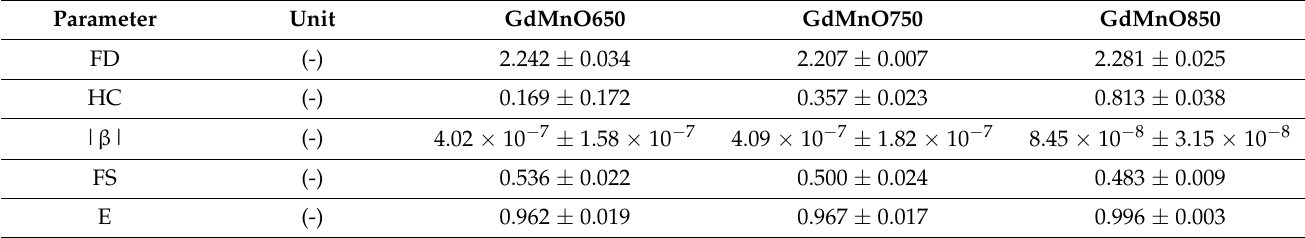
Table 5. Fractal and parameters advanced fractals of GdMnO 3 thin